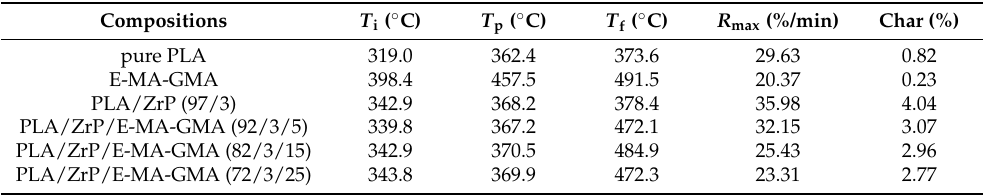
Figure 7. TGA curves of PLA, E-MA-GMA, PLA/ZrP, and PLA/ZrP/E-MA-GMA nanocomposites. Table 3. TGA results of PLA, E-MA-GMA, PLA/ZrP, and PLA/ZrP/E-MA-GMA